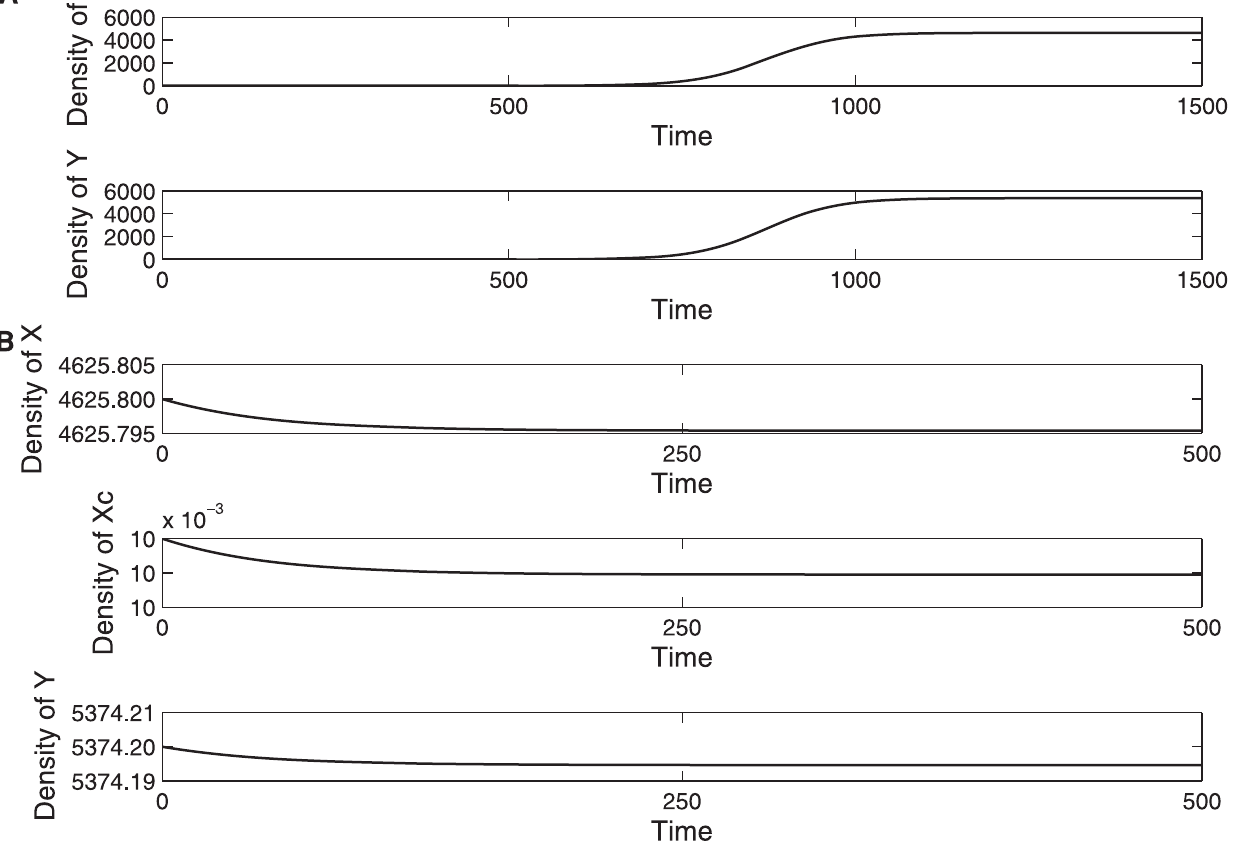
Figure 4. Evolutionary dynamics where mutants do not invade. A . Numerical simulations of the model (1) with r y =0.011, r x =0.008, ~ 1 . The figure shows an initial population X (0)= Y (0)=0.01 converging to a steady state ( X * ,Y * ). b xy = b yx =0.01, K =10000 and c y ~ c x ~ c x c B . Numerical simulations of the model (5) where a small amount of non-cross feeder ( X c (0)=0.01), is introduced into the steady state population ( X * ,Y * ). The figure shows that the cross-feeder X is not vulnerable to invasion by non-cross feeder X c . In addition to the above parameters r x